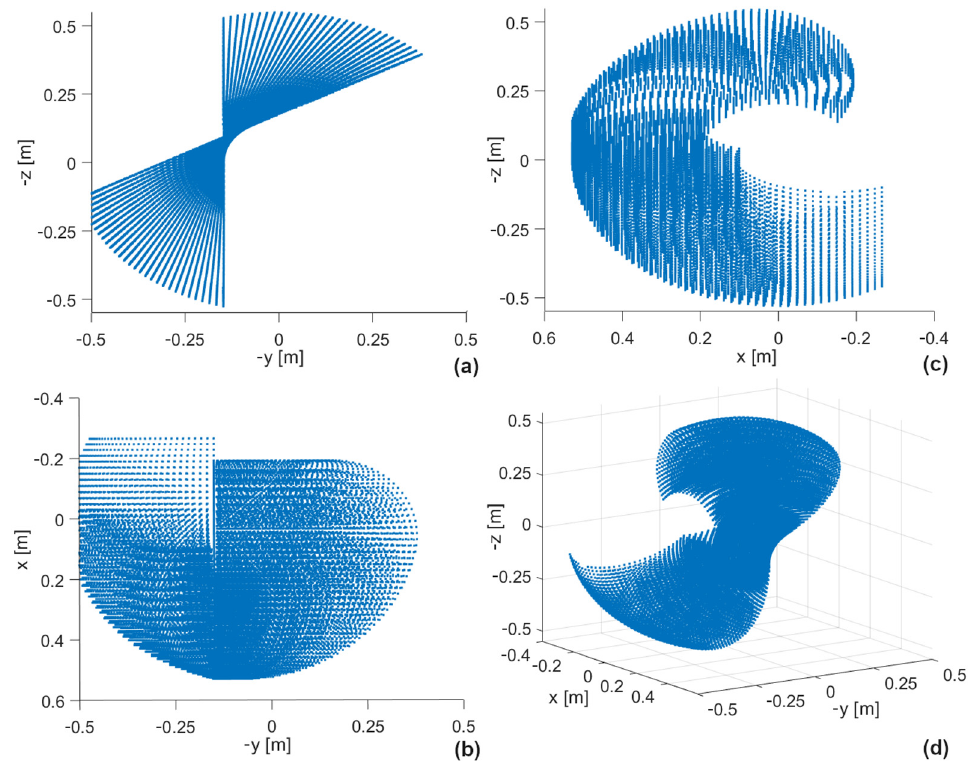
Figure 5. Workspace of the exoskeleton mechanical system (projections in three planes: ( a ) zy , ( b ) xy , ( c ) zx and ( d ) 3D ). ( c ) zx and ( d ) 3D